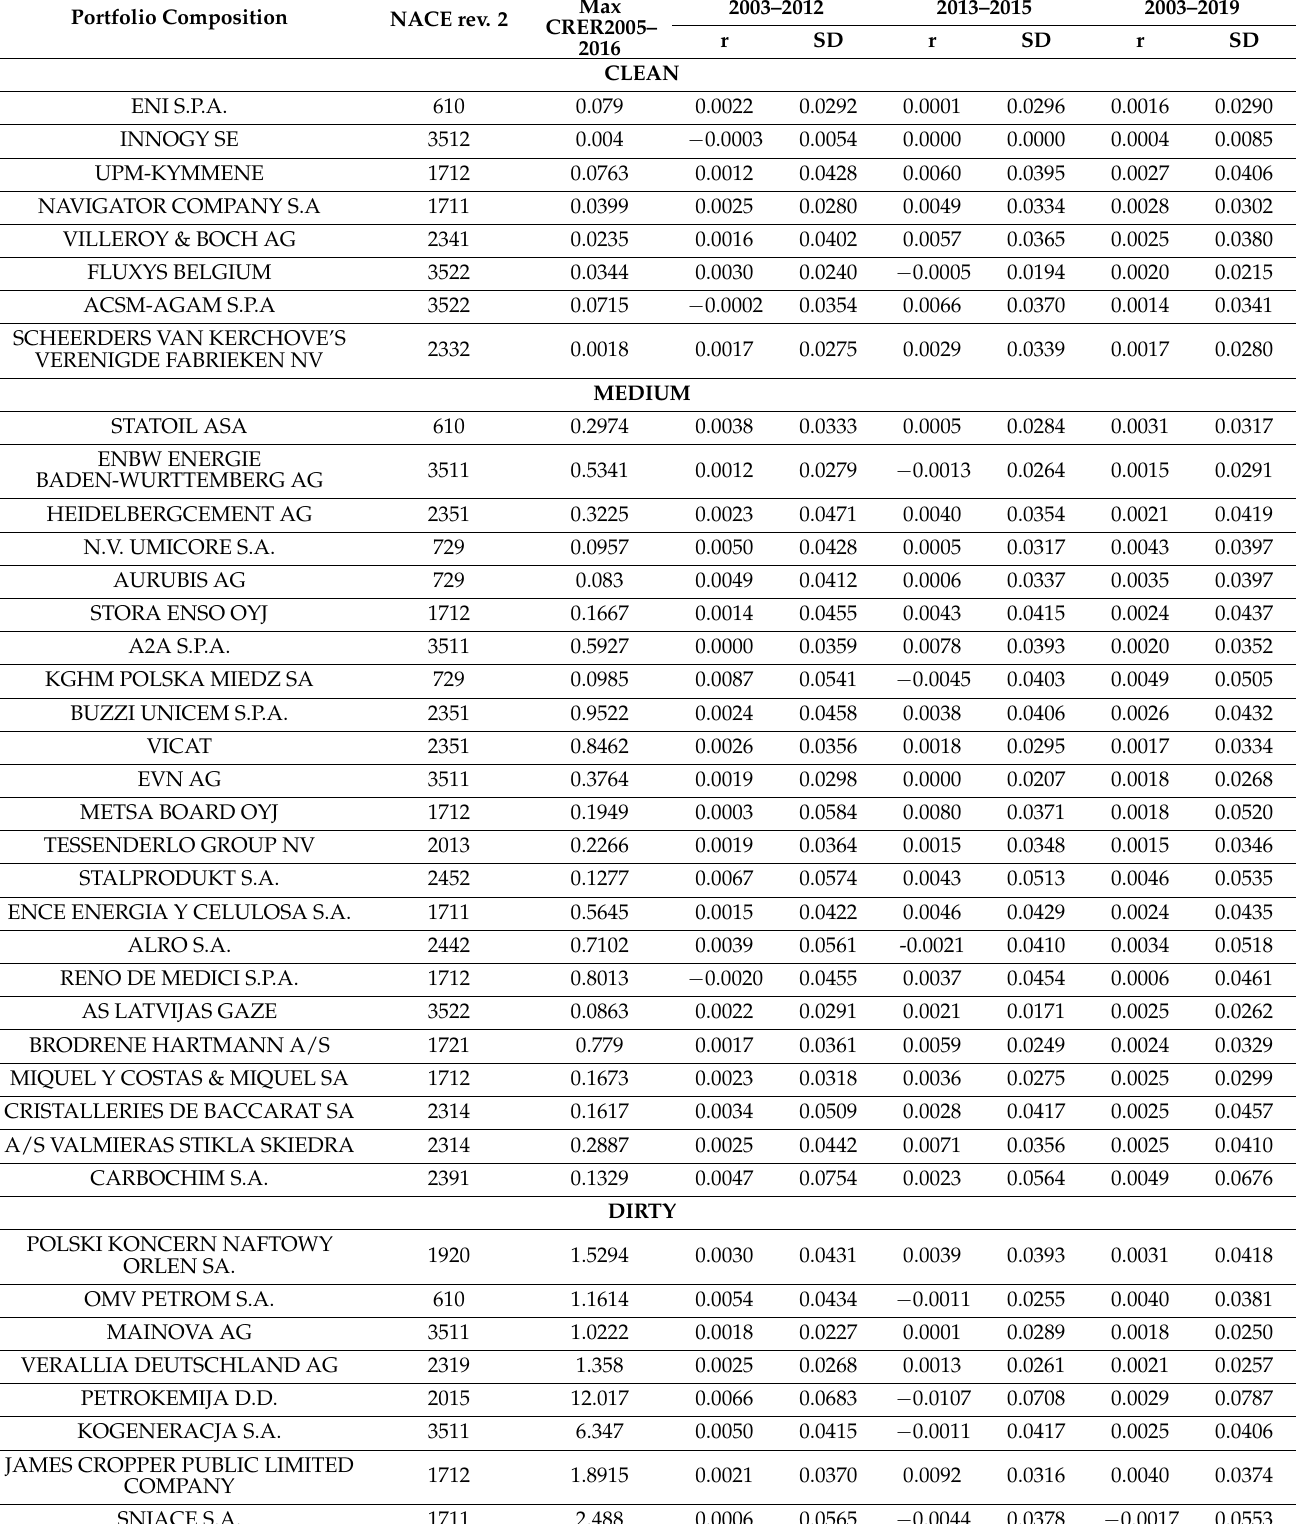
Table A2. Portfolio composition and basic descriptive